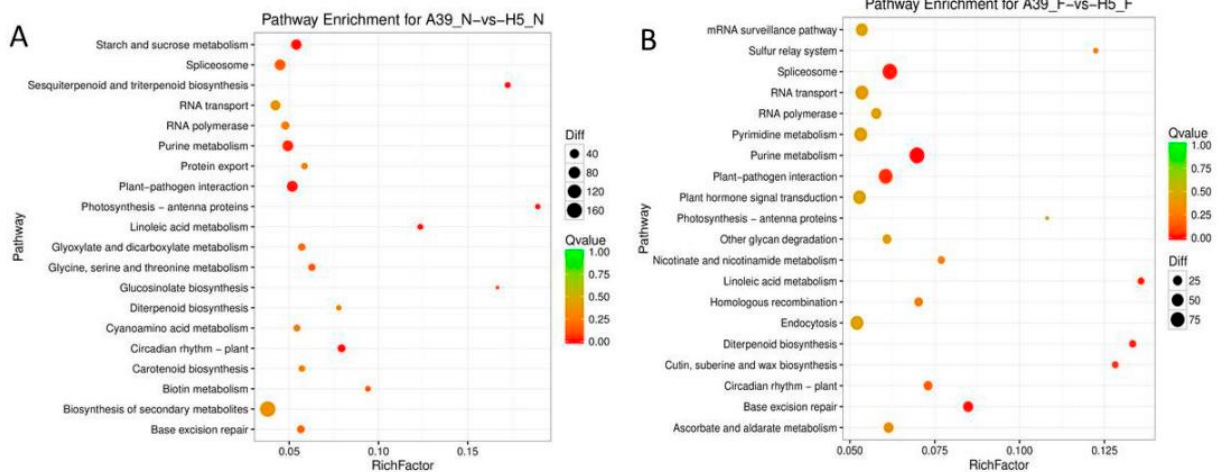
Figure 5. The top 20 significantly enriched KEGG pathways in the seedlings. ( A ) Normal conditions: ‘A39’_N-vs. ‘H5’_N. ( B ) FA stress: ‘A39’_F-vs. ‘H5’_F. The y-axis represents different KEGG pathways and the x-axis represents enrichment factors. Larger circles indicate more DEGs in the pathway and higher Q-value is indicated by green color.